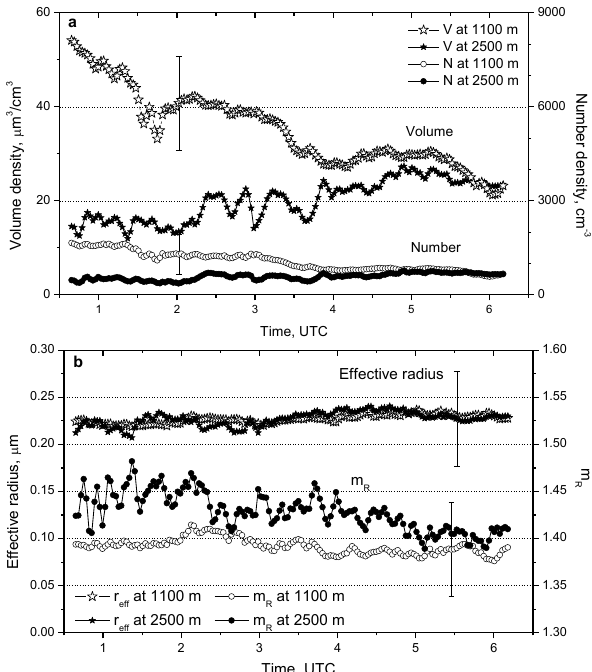
Fig. 6. Time series of (a) particle volume and number density to- gether with (b) effective radius and real part of the refractive in- dex obtained from lidar measurements on 21 July 2011. The lidar- derived parameters are averaged in layers of 200m thickness and centered at 1100m (open symbols) and 2500m (solid symbols).